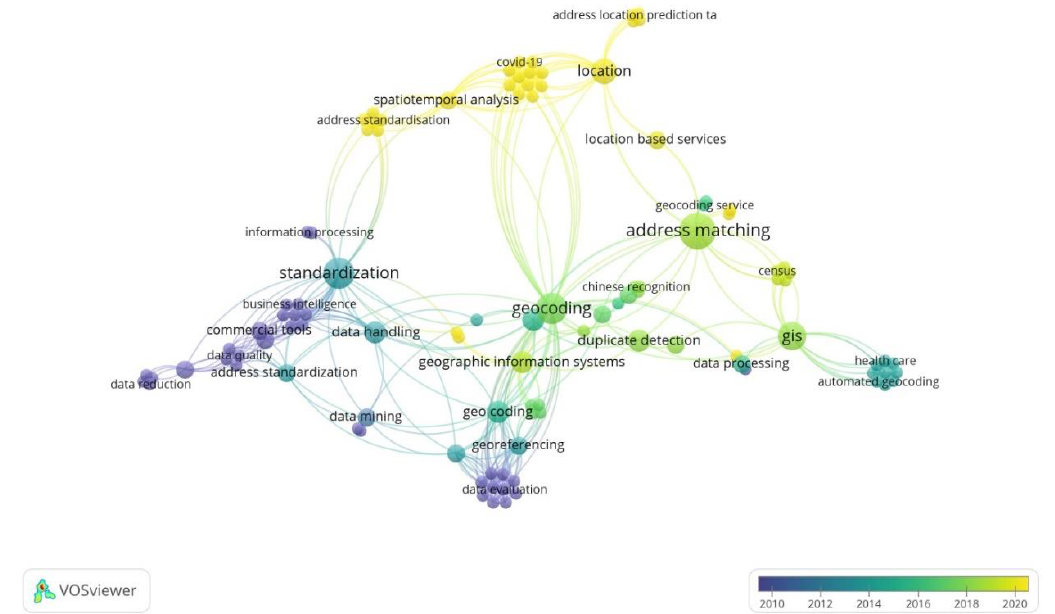
Figure 8. Application domains by average publication year.